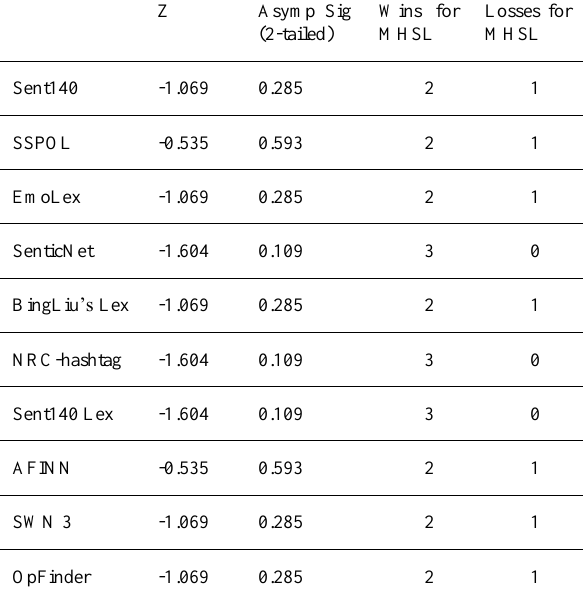
Table 7. Results of Wilcoxon Signed Rank Test for accuracy values of MHSubLex with GA and baselines.